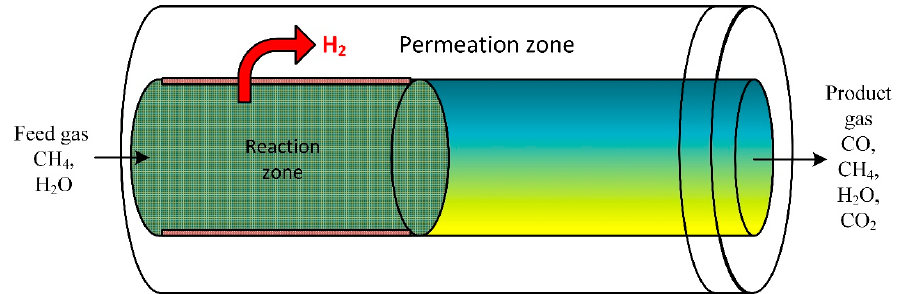
Figure 7. Schematic of a packed bed reactor assisted by membrane [85].